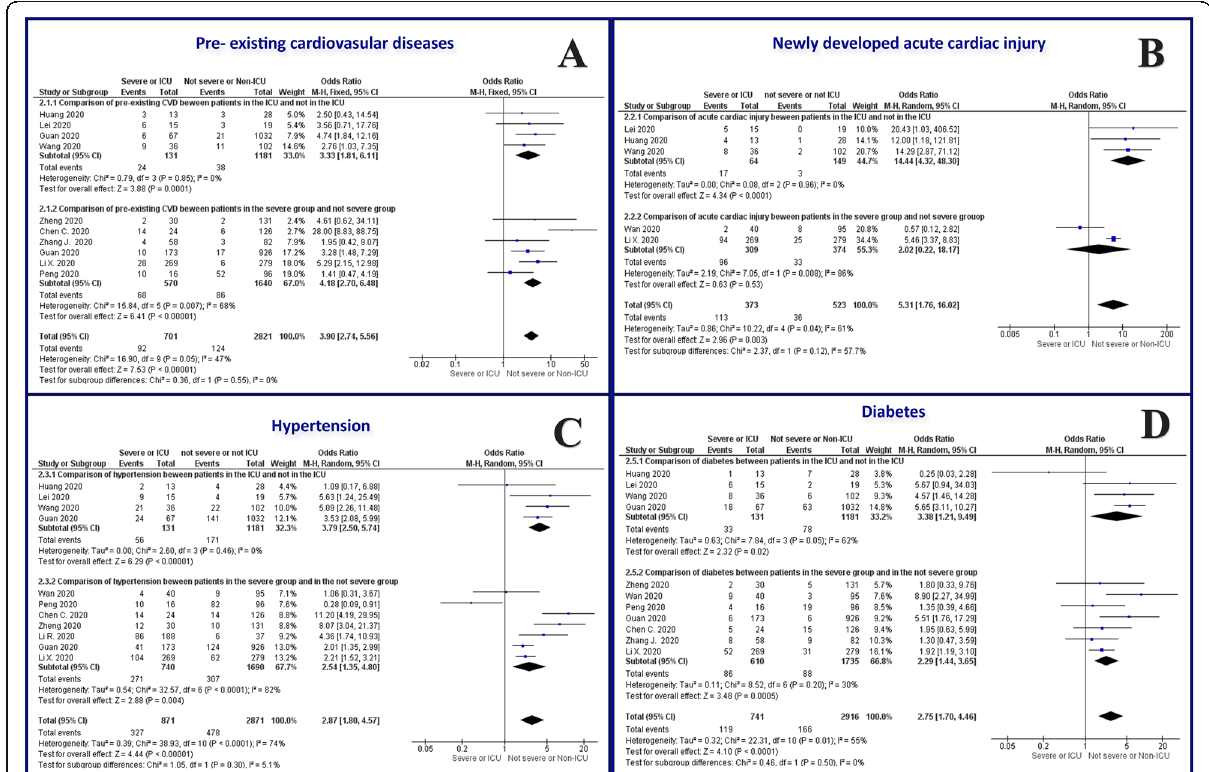
Fig. 4 Forest plots showing the odds ratio for severity according to the newly developed acute cardiac injury, pre-existing cardiovascular disease, hypertension and diabetes